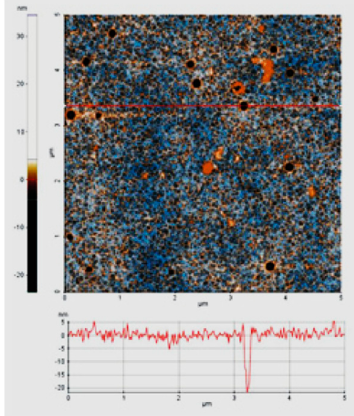
Figure 12. AFM image of SnO 2 films [115].